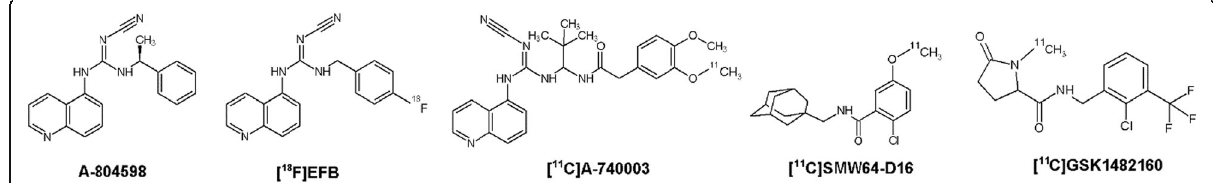
Fig. 1 Chemical structures of A-804598 and of the P2X7 PET tracers described to date in the literature, including our novel P2X7 ligand [ 18